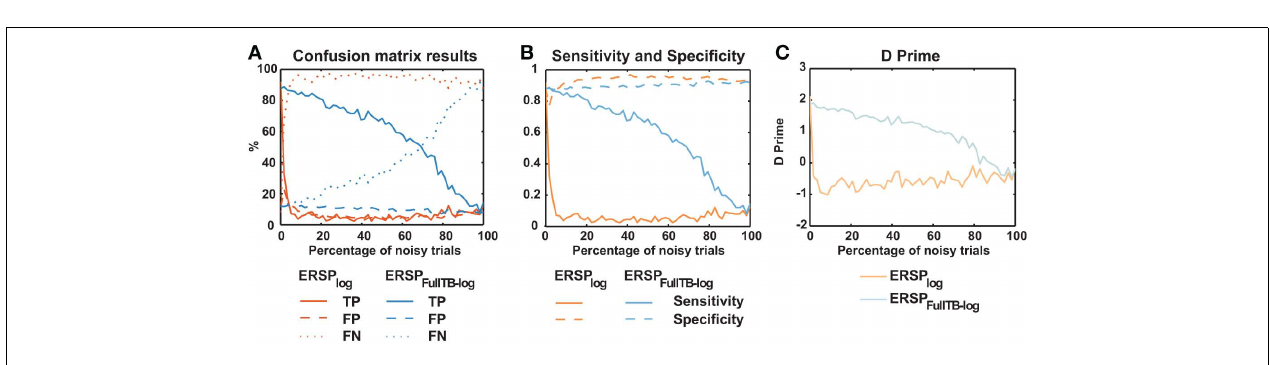
FIGURE 4 | Confusion matrix, sensitivity, specificity, and d (cid:2) results of the ERSP classical method and the ERSP using single-trial correction. (A) True Positives (TP), False Positives (FP) and False Negatives (FN) significant results for the ERSP log and ERSP FullTB − log .The single-trial-based method